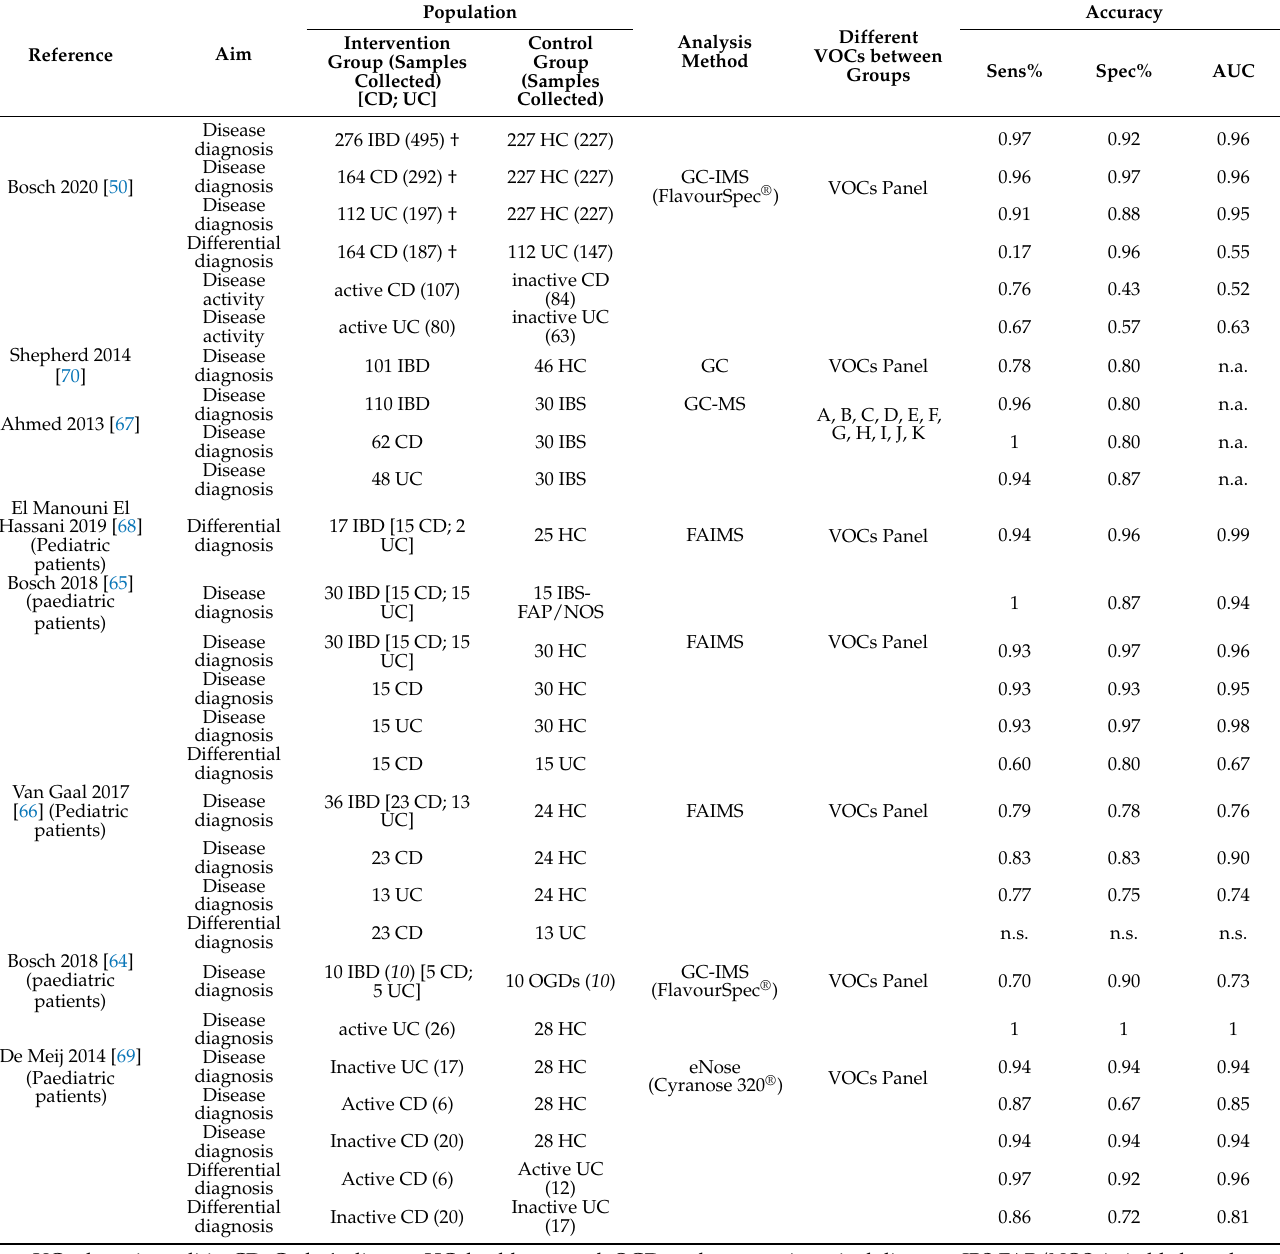
Table 6. Fecal VOCs and IBD diagnosis and activity